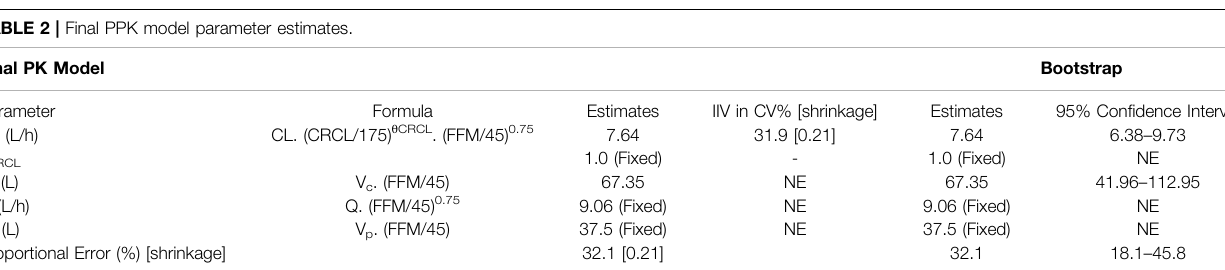
TABLE 2 | Final PPK model parameter